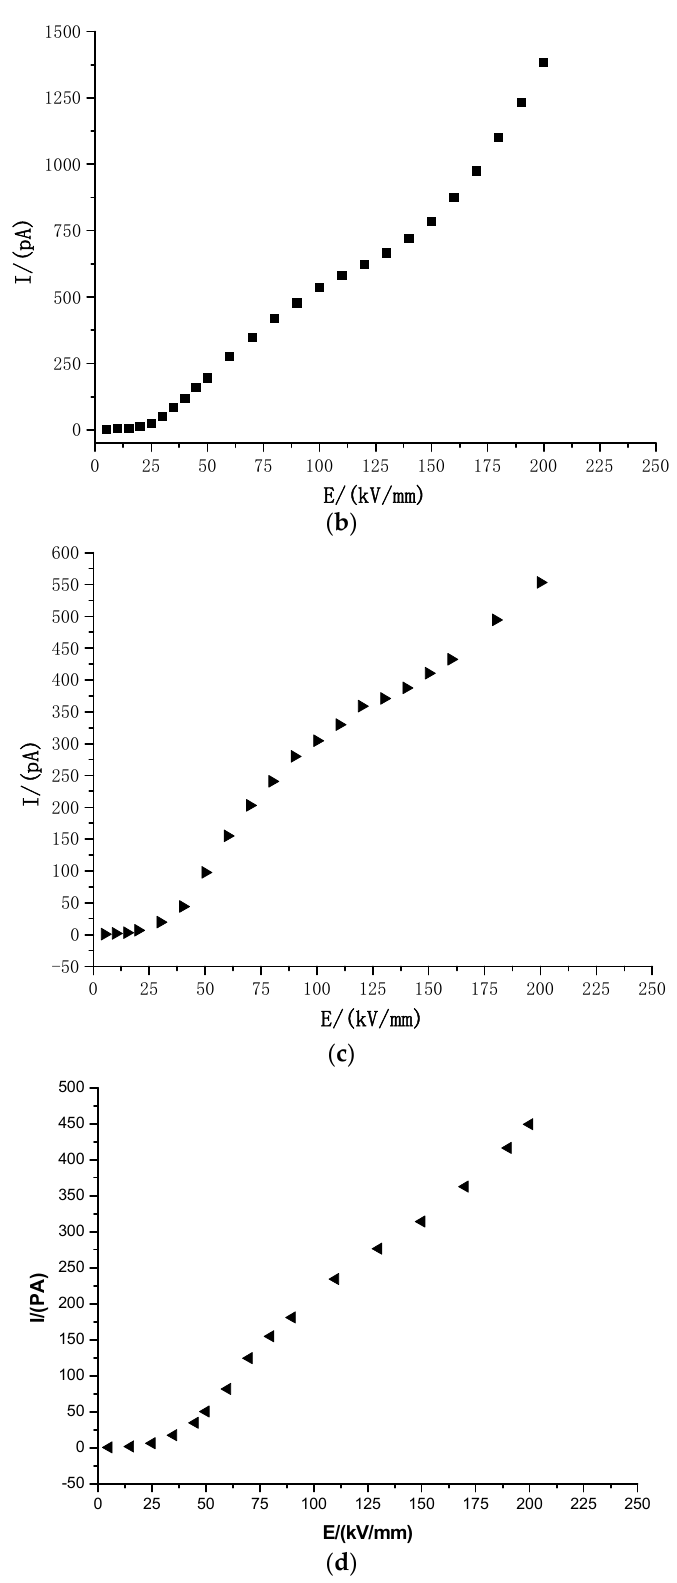
Figure 6. Conduction current characteristic curve of polyethylene with different densities. ( a ) LDPE; ( b ) LLDPE; ( c ) MDPE; ( d ) HDPE.